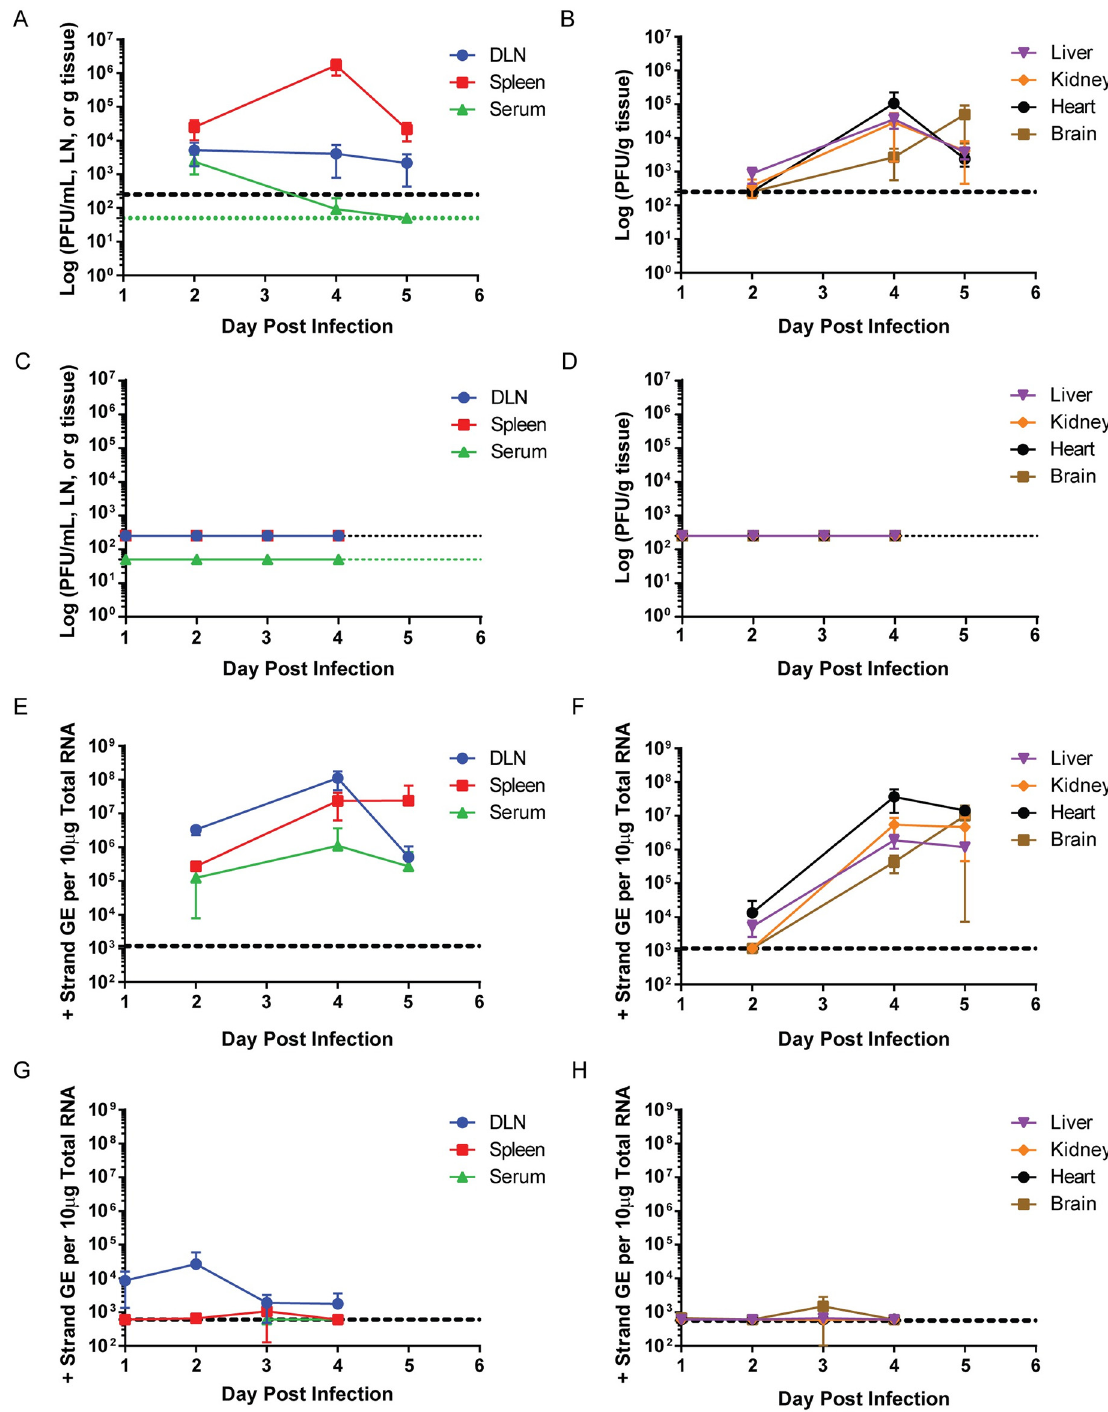
Fig 4. Immunization with 17D-204 restricts replication of wtYFV following challenge. (A-B, E-F) Naive or (C-D, G-H) 17D- 204-vaccinated 8 week old mice were infected s.c. with Ang71. On the indicated days p.i., tissues were harvested and (A-D) PFU or (E-H) genomic equivalents [GE] were determined by (A-D) standard plaque assay or (E-H) RT-qPCR (n = 6 for all groups). The black hashed line indicates the (A-D) limit of detection [LD] or (E-H) limit of quantification [LOQ]. (A, C) The green hashed line indicates the LD for serum